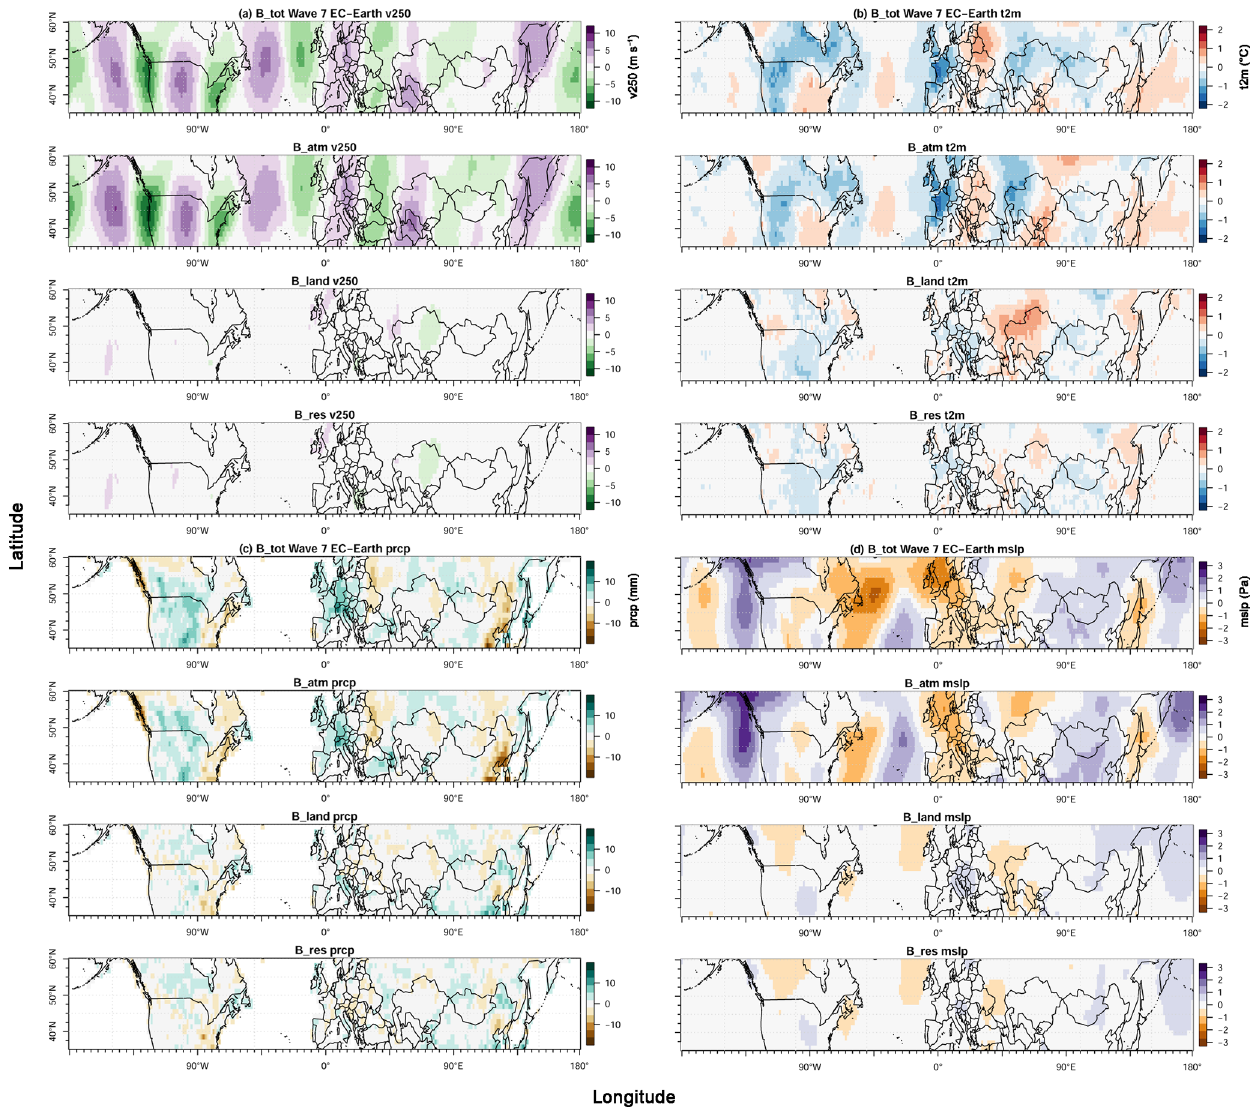
Figure 8. Bias plots for high-amplitude wave-7 events and episodes in different experiments for EC-Earth. Total bias (B_tot), atmospheric bias (B_atm), land–atmosphere interaction bias (B_land), and residual bias (B_res) for meridional wind velocity at 250hPa (a) , surface temperature (b) , precipitation (c) , and sea level pressure (d)